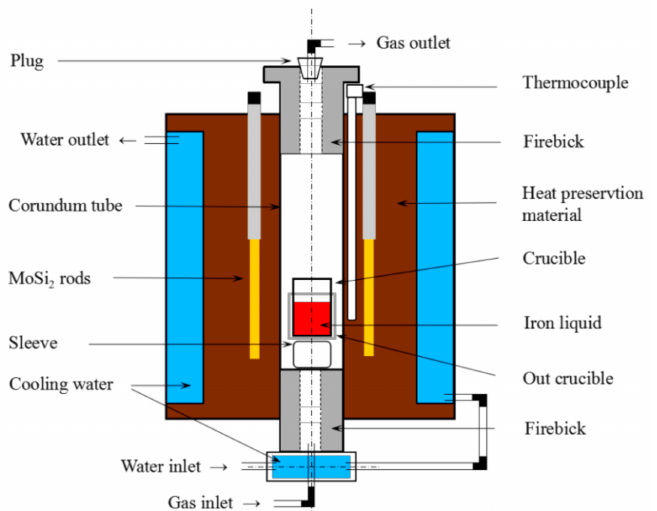
Figure 1. The experimental